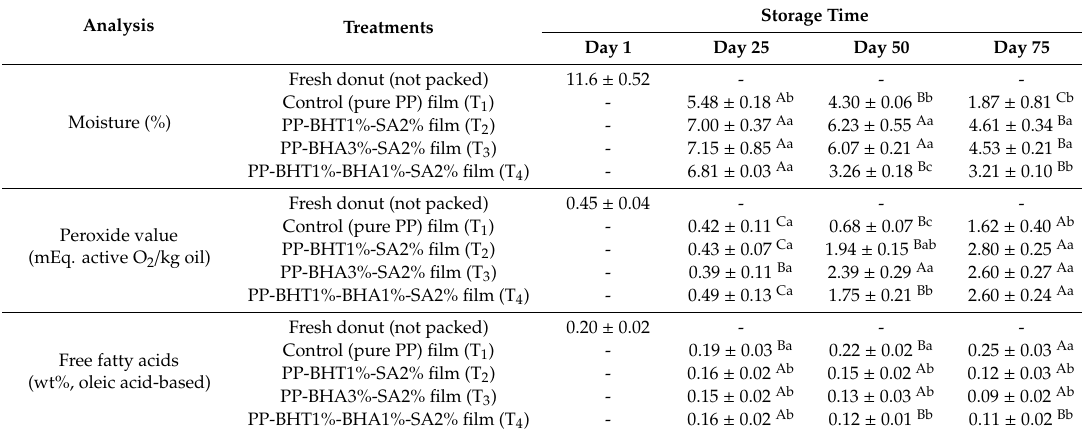
Table 3. Moisture content, peroxide value and free fatty acid contents of fresh and packed donuts in di ff erent PP-based active films during storage